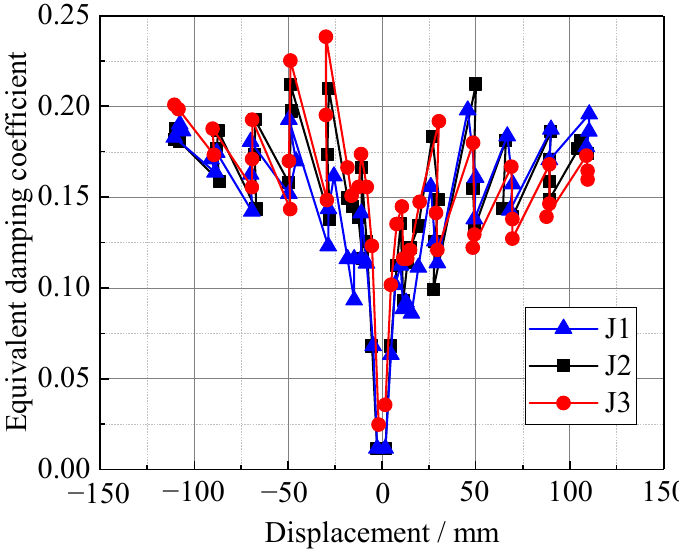
Figure 35. Bolt stress cloud.